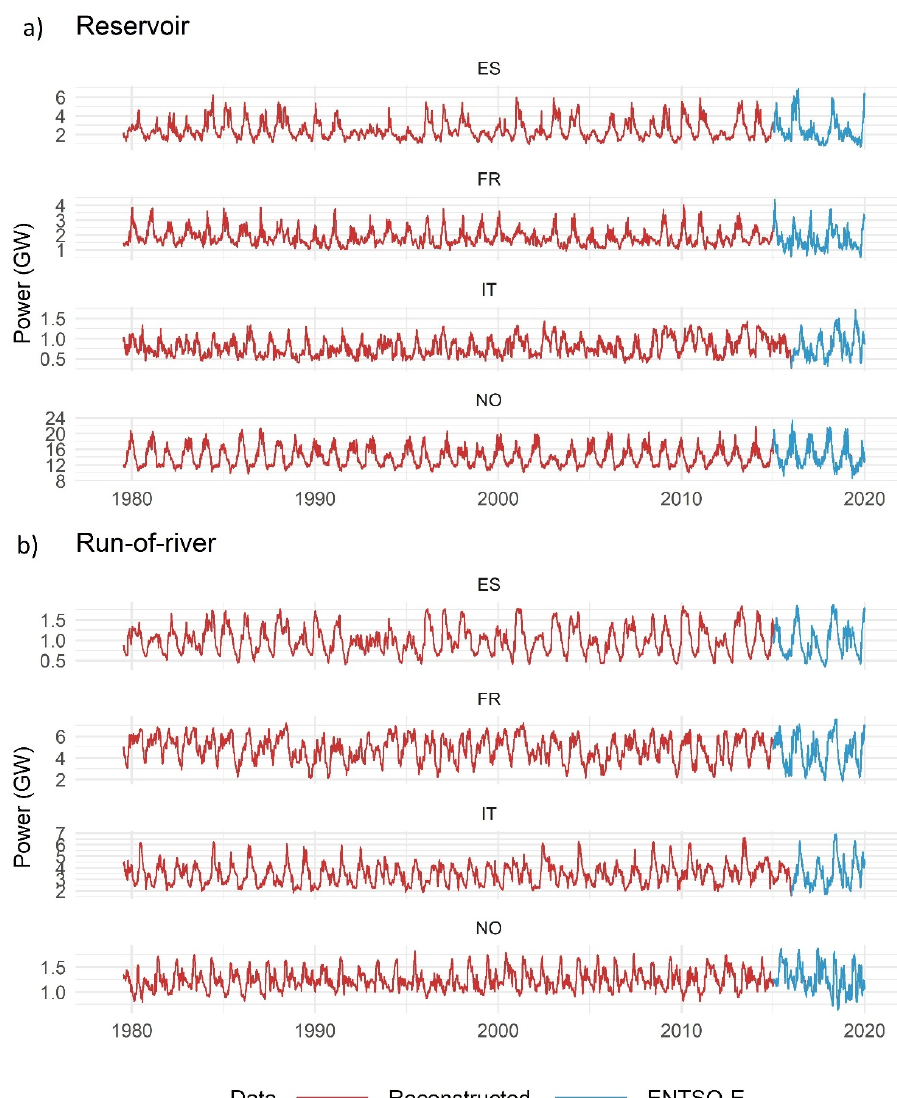
Figure 4. Result of the model for the four countries with largest installed capacity, Spain (ES), France (FR), Italy (IT), and Norway (NO): 7 day rolling mean of reconstructed hydro power generation (GW) for reservoir-based ( a ) and run-of-river ( b ) generation for the period 1979–2019, namely a subset of the reconstructed dataset 1979–2019. Red line: reconstructed data; blue line: ENTSO-E data. As the model was trained for the period 2015–2019, the blue curve appears as overlapping with the red curve over this period.